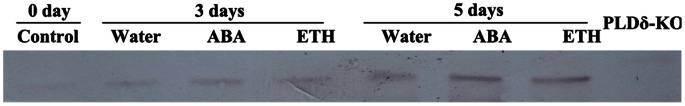
Changes in PLDδ abundance in detached Arabidopsis leaves floated on water, ABA, or ethylene.Total protein (40 µg) was extracted from WS leaves treated with either water, 50 µM ABA, or 50 µM ethephon (ETH) for 0, 3, and 5 days and separated by SDS-PAGE. PLDδ was detected by western blotting using a PLDδ-specific antibody. Protein from PLDδ-KO leaves that underwent no additional treatment is shown as a negative control.